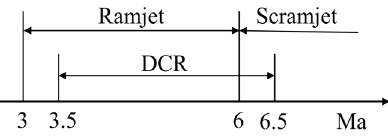
Figure 1. Operating Mach number range for different types of engines.